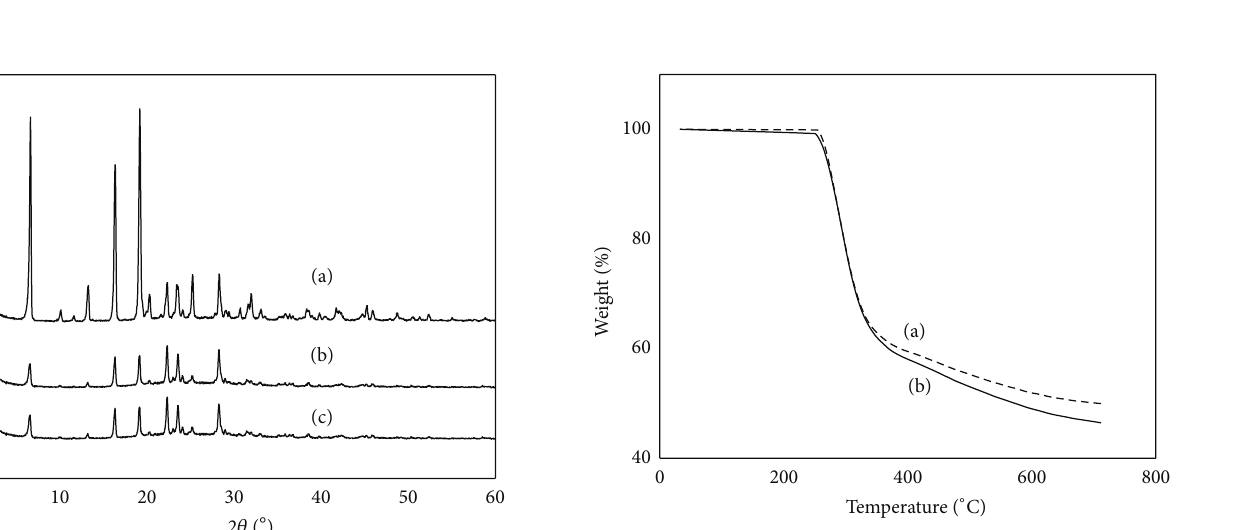
Figure 6: LC-MS spectra of r-Res (a) and u-Res (b).